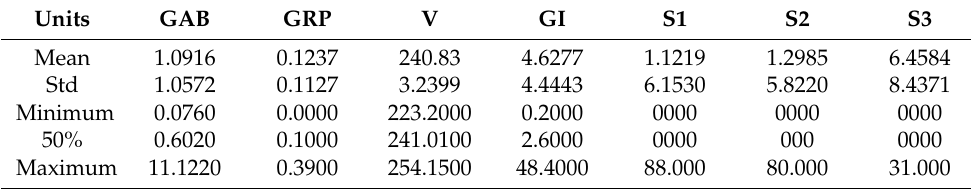
Table 6. Quantitative structure of the power consumption dataset.